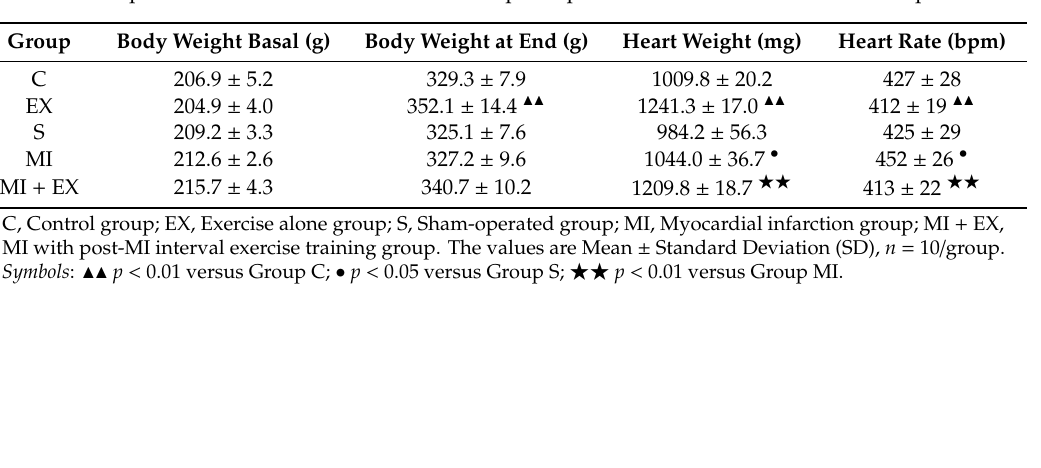
Table 1. Morphometric characters of the animals at pre-experiment baseline and at the end of protocol. Group Body Weight Basal (g) Body Weight at End (g)